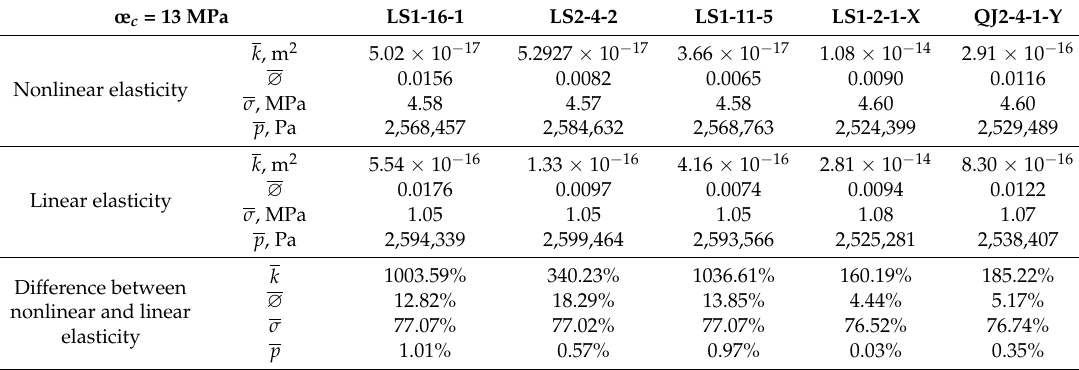
Table 4. Average property values for confining stress of 13 MPa and comparison with the linear elasticity case.